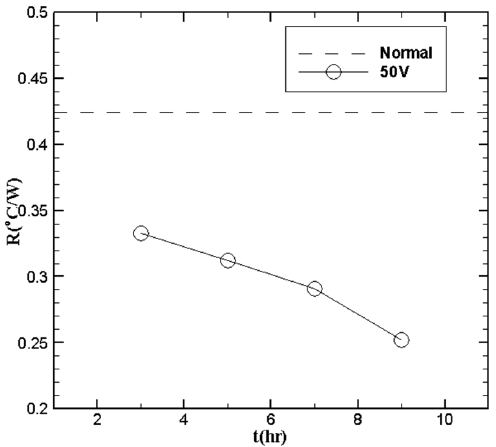
Figure 7. Variation of the overall thermal resistance with the treatment time under an input heat power of 100 W at an anodizing voltage of 50 V.